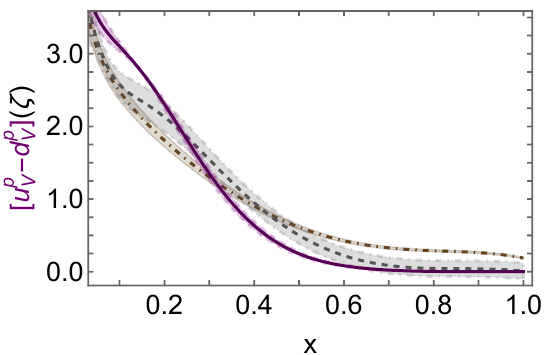
Figure 24. Isovector distribution [ u p ( x ; ζ ) − d p ( x ; ζ )] . CSM prediction—solid purple curve, ζ = ζ 3 ; lQCD result from Reference[428]—dashed grey curve, ζ = ζ 3 ; lQCD result from Reference[429]— dotted-dashed brown curve, ζ = ζ 2 . Like-coloured band bracketing each curve indicates associated